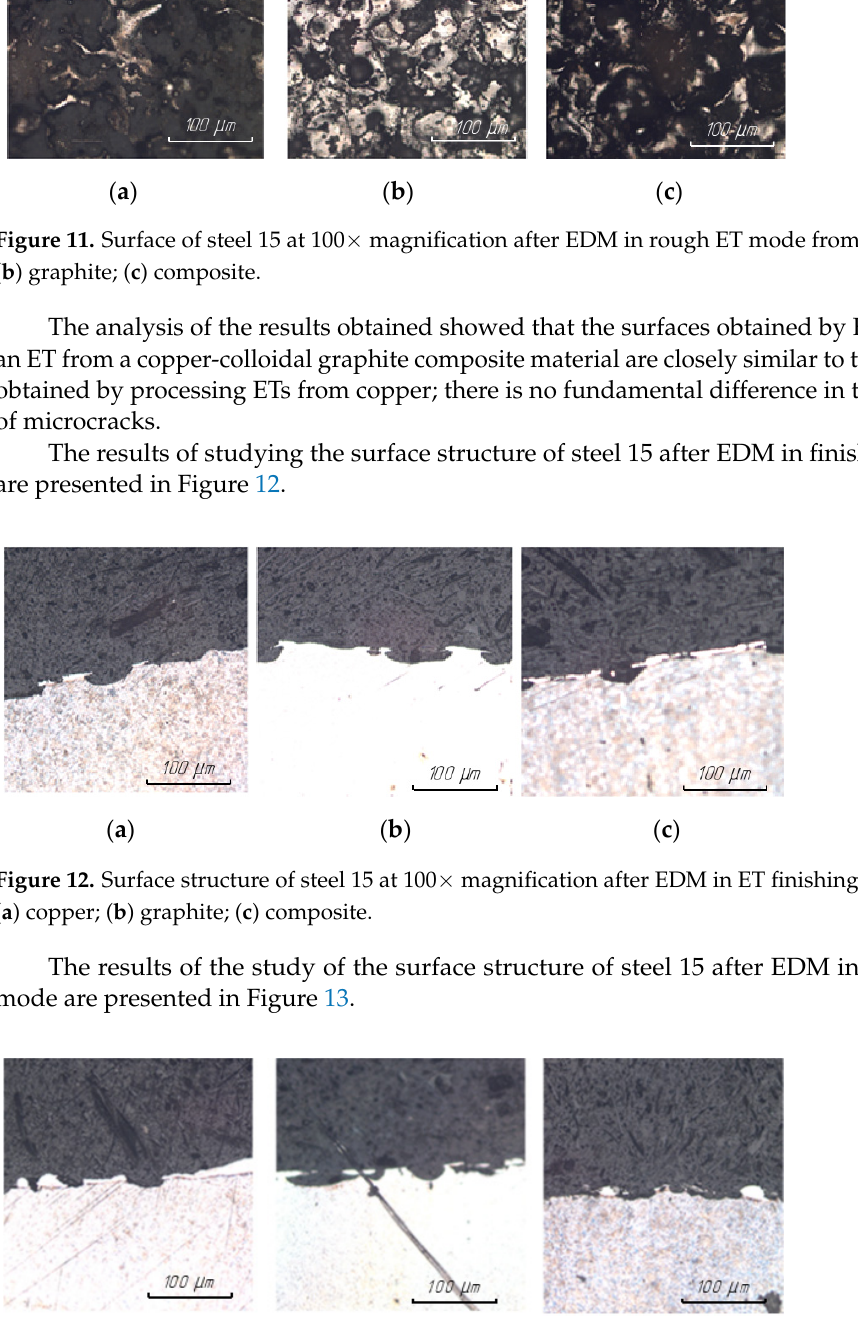
Figure 10. Surface of steel 15 at 200× magnification after EDM in ET finishing mode from: ( a ) copper; ( b ) graphite; ( c ) composite.